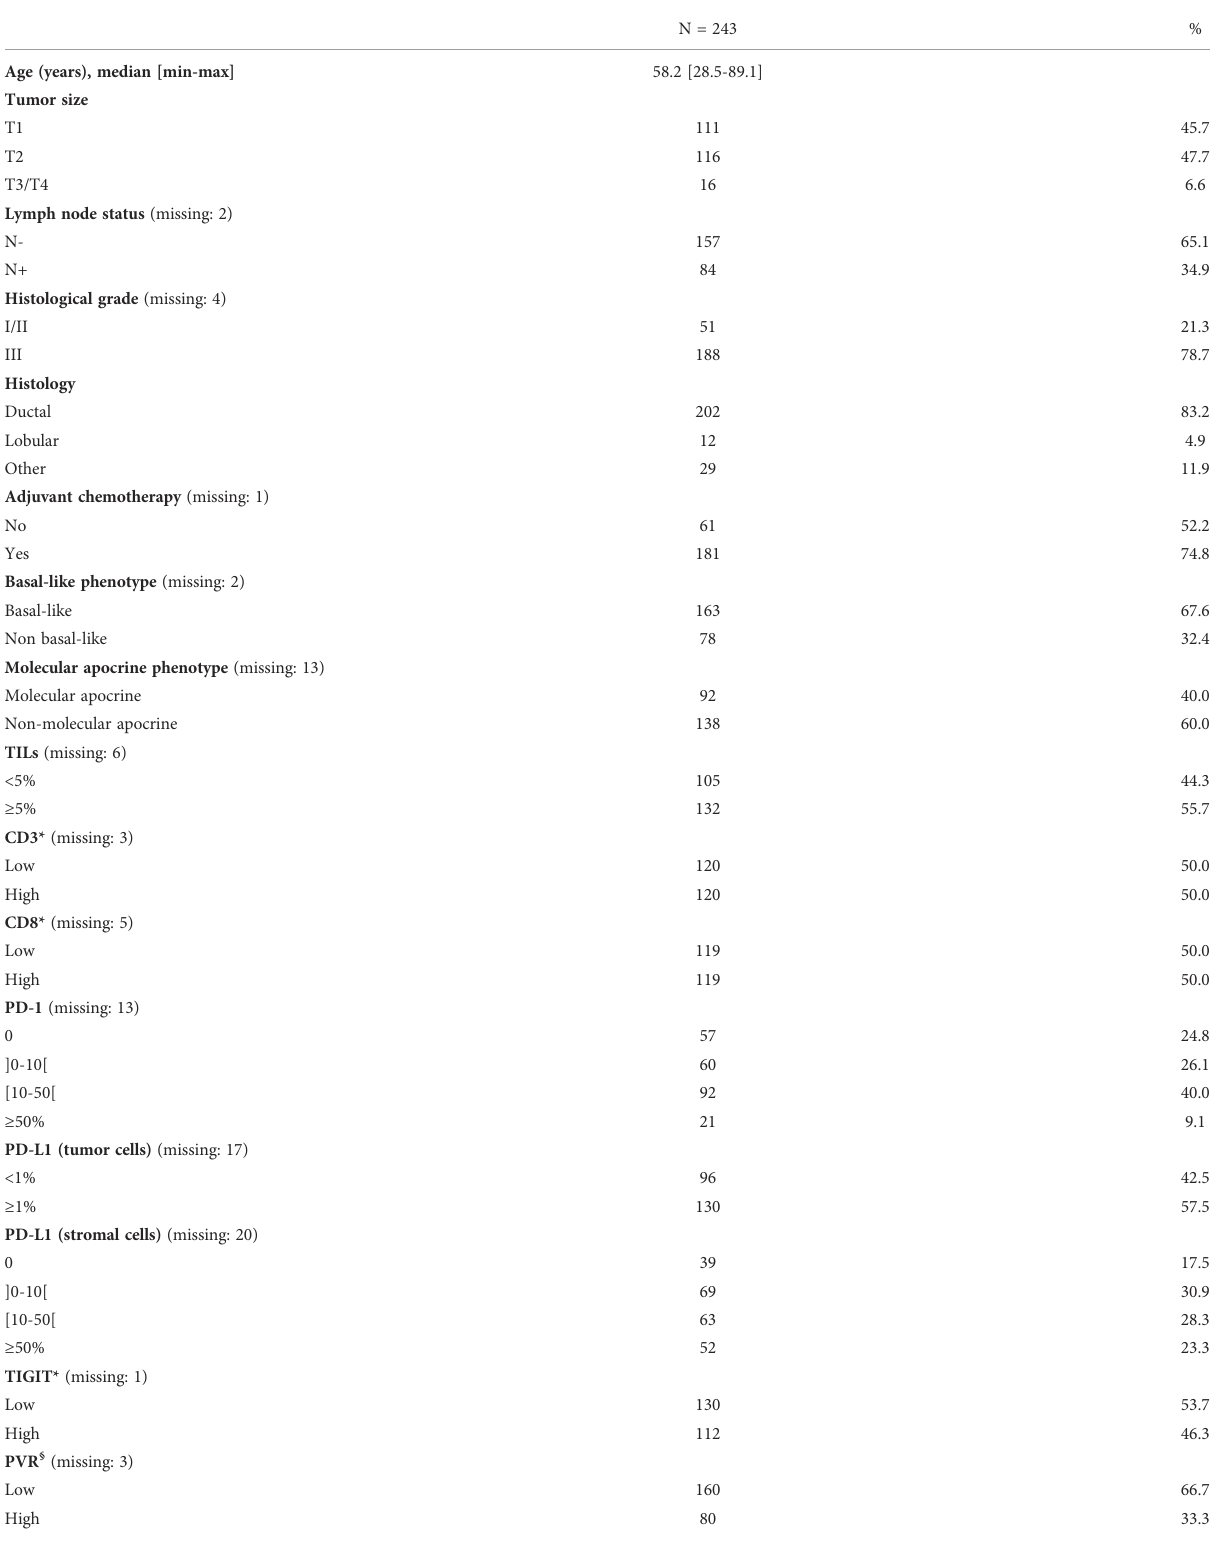
TABLE 1 Clinicopathological features of the TNBC